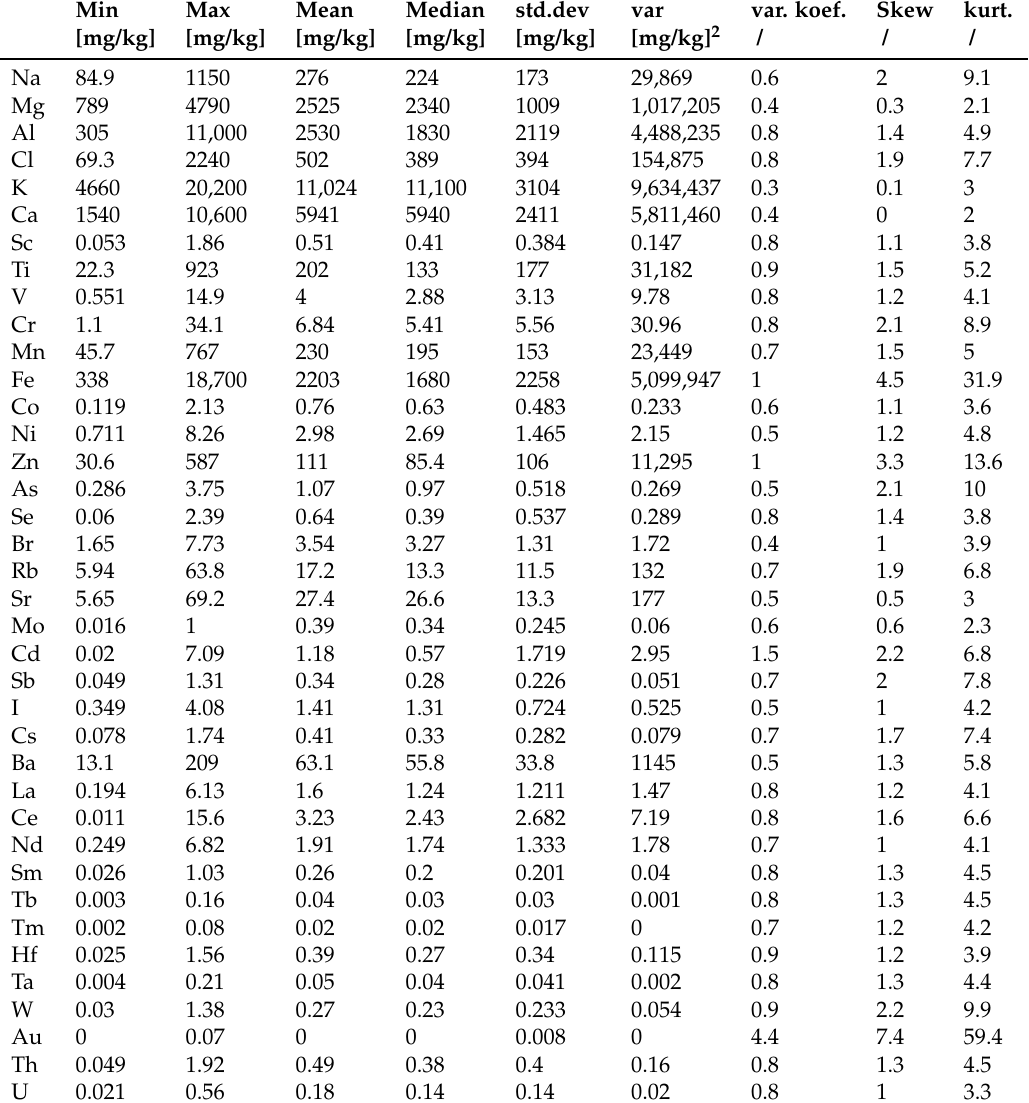
Table 1. Descriptive statistics of measurement, n =